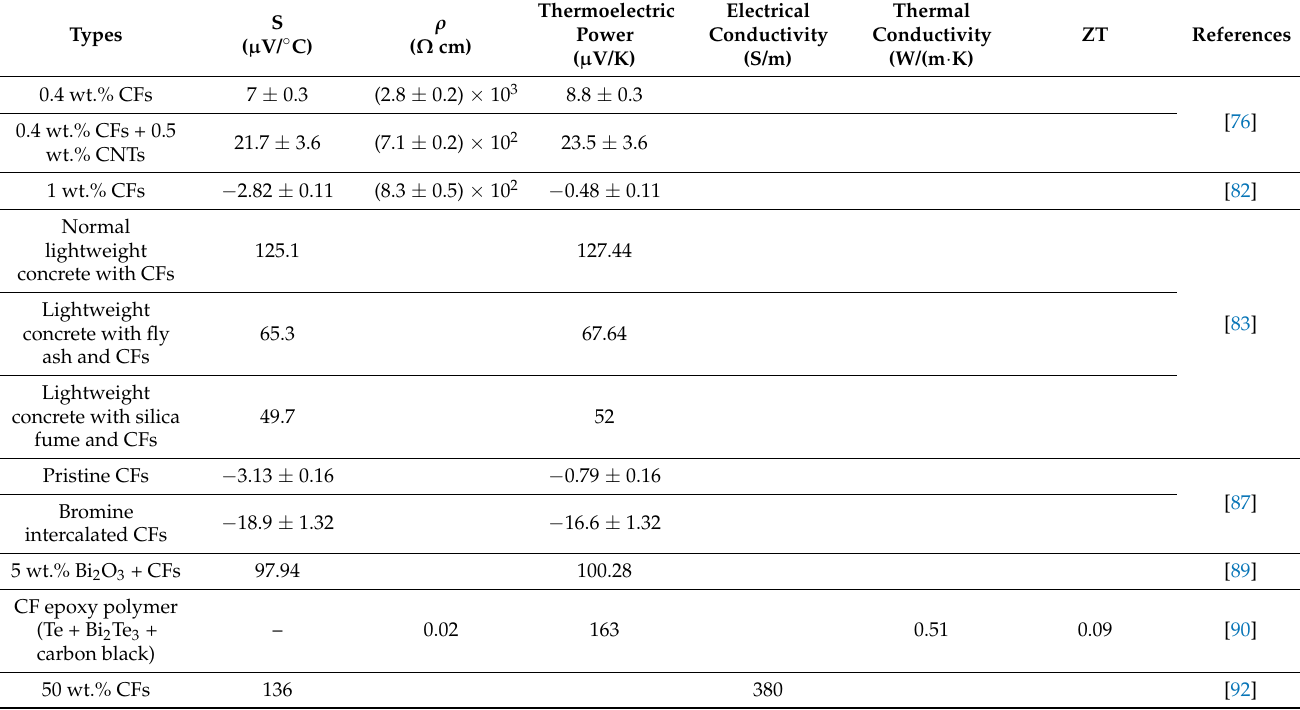
Table 4. Thermoelectric properties of